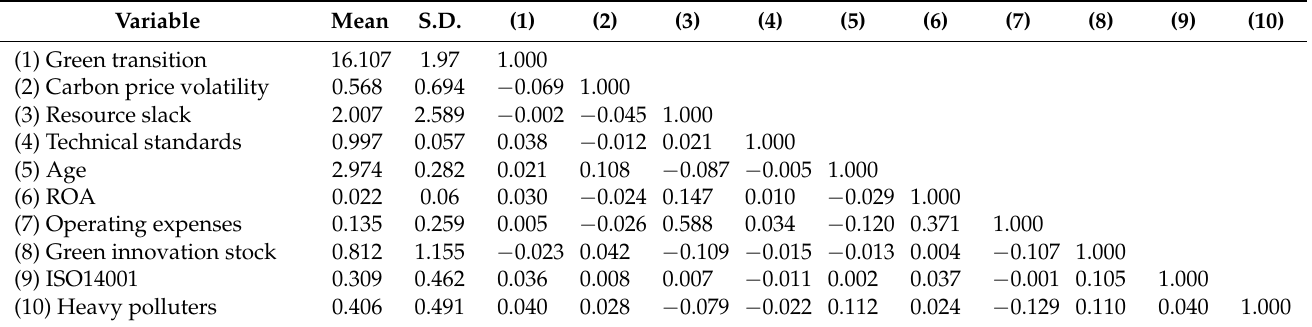
Table 1. Descriptive statistics and